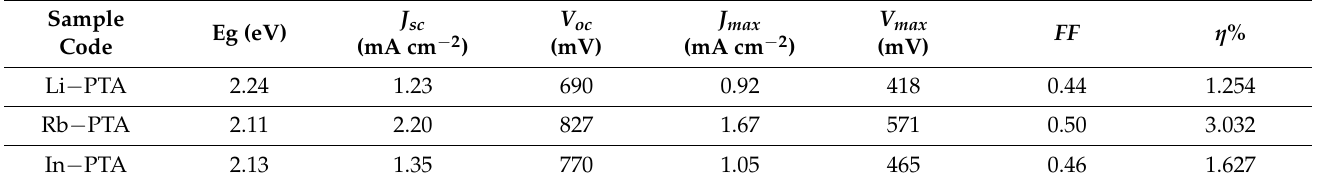
Table 3. Photoelectrochemical parameters of Li − PTA, Rb − PTA, and In − PTA